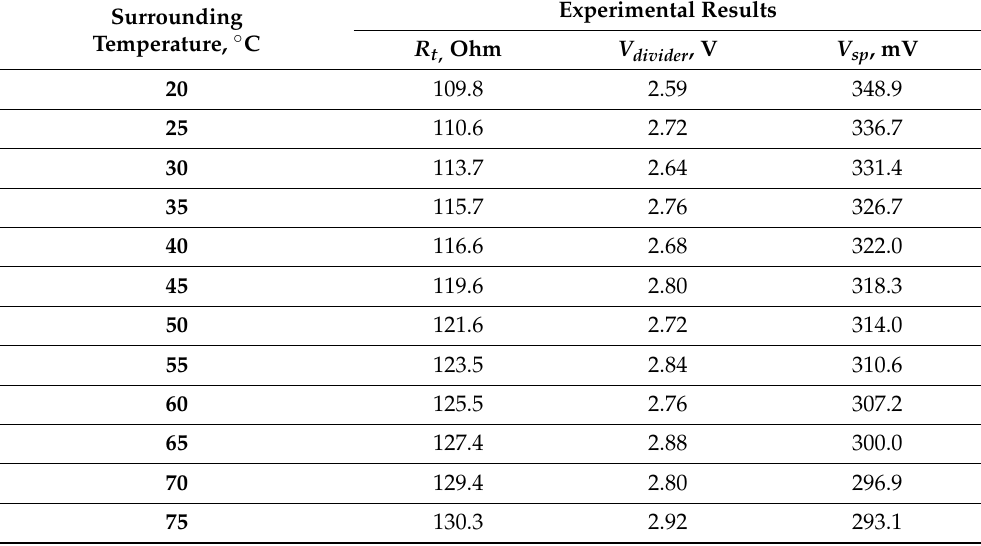
Table 1. Experimental